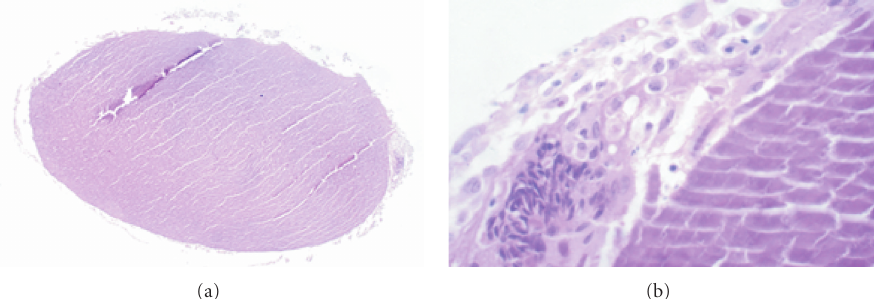
Figure 2: (a) Section shows lens with surrounding inflammatory infiltrates (hematoxylin and eosin, × 100). (b) The higher magnification shows inflammatory cells consisting of polymorphonuclear cells, histiocytes, and engulfed lens matter and multinucleated giant cells (periodic acid Schi ff ’s Stain, ×